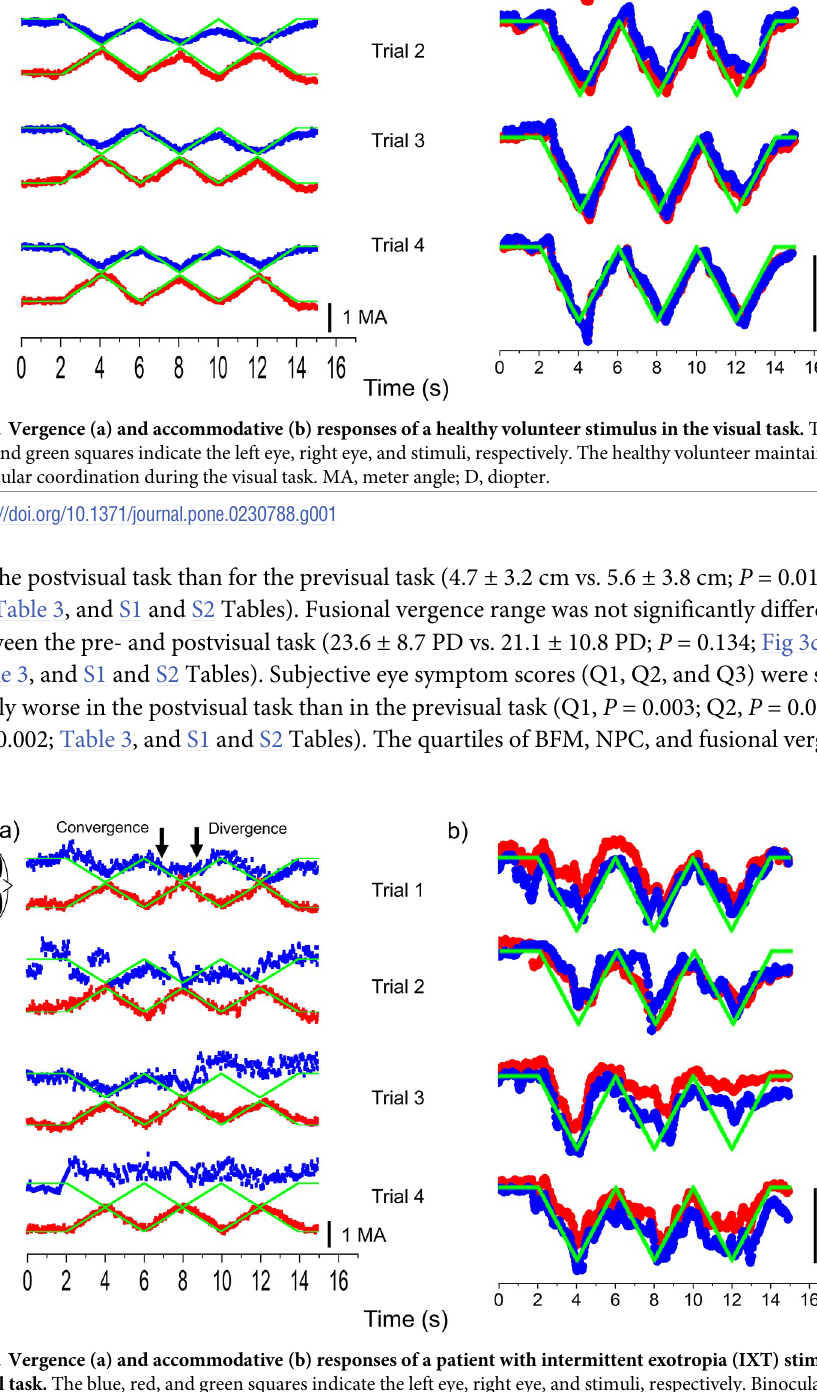
Fig 2. Vergence (a) and accommodative (b) responses of a patient with intermittent exotropia (IXT) stimuli in the visual task. The blue, red, and green squares indicate the left eye, right eye, and stimuli, respectively. Binocular coordination in the patient with IXT was gradually disrupted during the visual task. MA, meter angle; D, diopter.